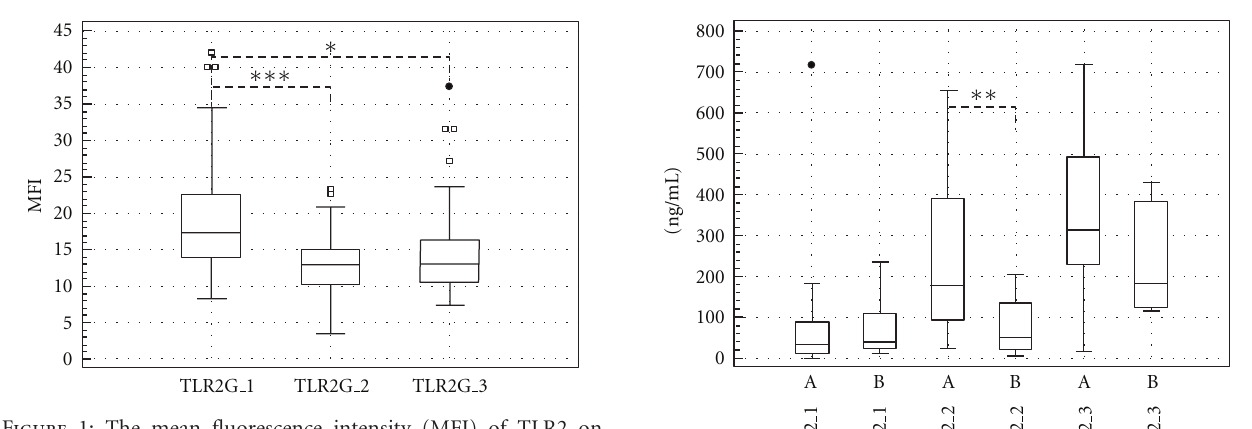
Figure 1: The mean fluorescence intensity (MFI) of TLR2 on membrane of granulocytes in pleural e ff usion fluid at three sampling points: 1—before thoracoscopic procedure, 2—2 hours after terminating talc insu ffl ation procedure, 3—24 hours after talc insu ffl ation procedure. (Line: median; boxes: quartiles; whiskers: